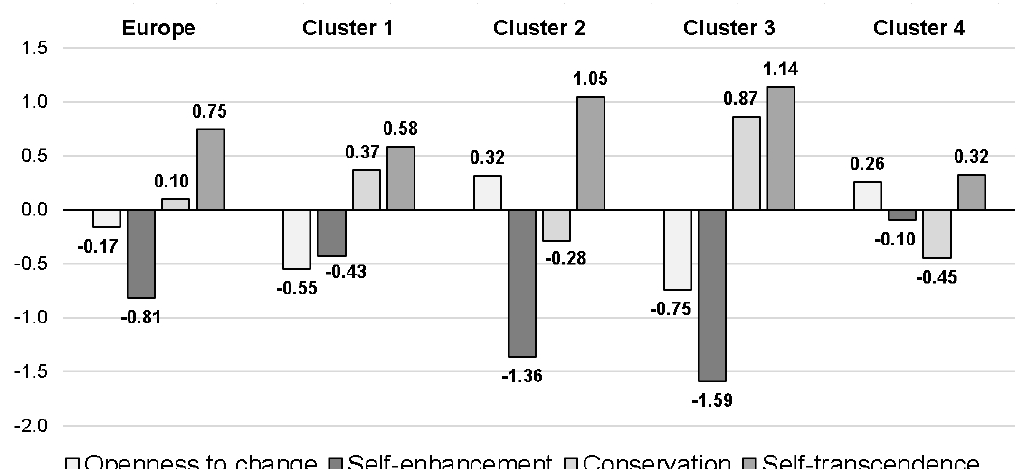
Figure 2. Comparison of the mean Schwartz’s higher order value priorities for Europe and the four clusters found.